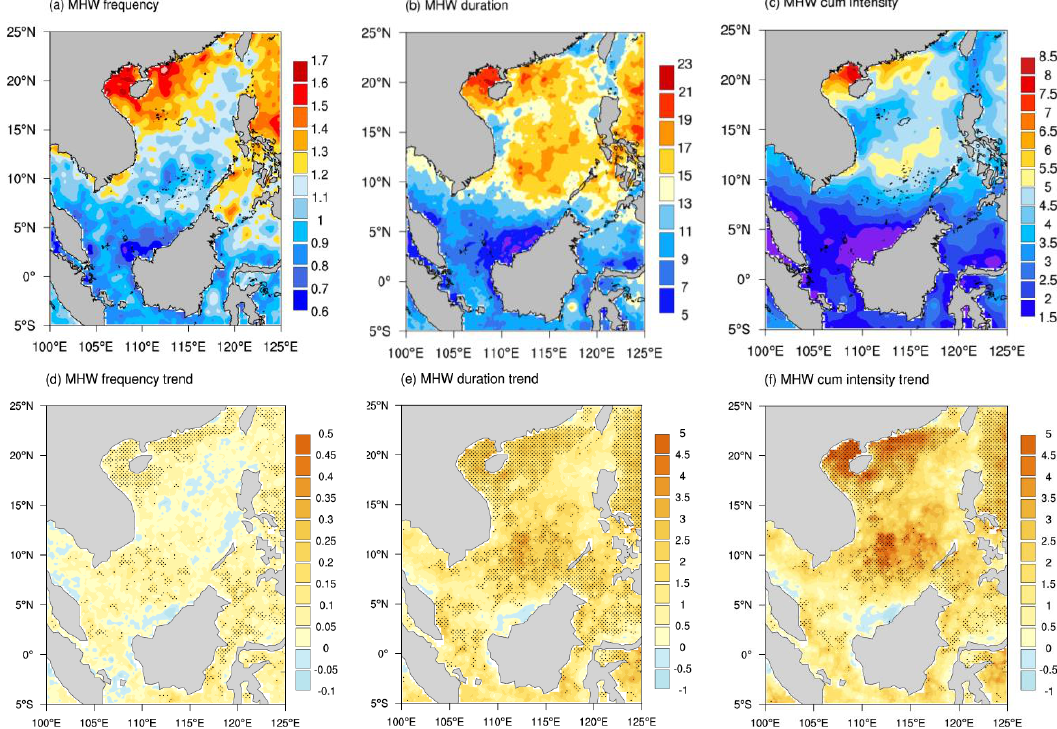
Figure 2. Spatial distribution of the multiyear warm season (1982–2020) averaged MHWN (units: Count) ( a ); MHWD (units: days) ( b ); and MHWI (units: °C •days) ( c ) in the SCS; Spatial distribution of long-term trends of warm season MHWN ( d ) (unit: count per decade); MHWD ( e ) (unit: days decade); MHWI ( f ) (unit: °C •days per decade). The black dots indicate statistically significant trends at 0.05 level using the Mann – Kendall test of each grid point.